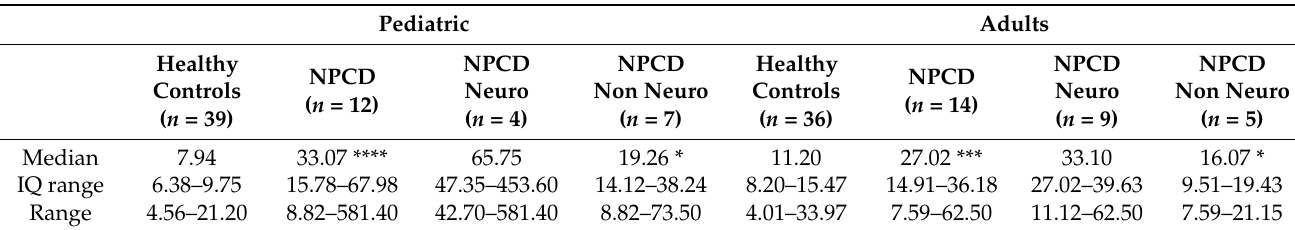
Table 3. Plasma levels of NfL (pg/mL).